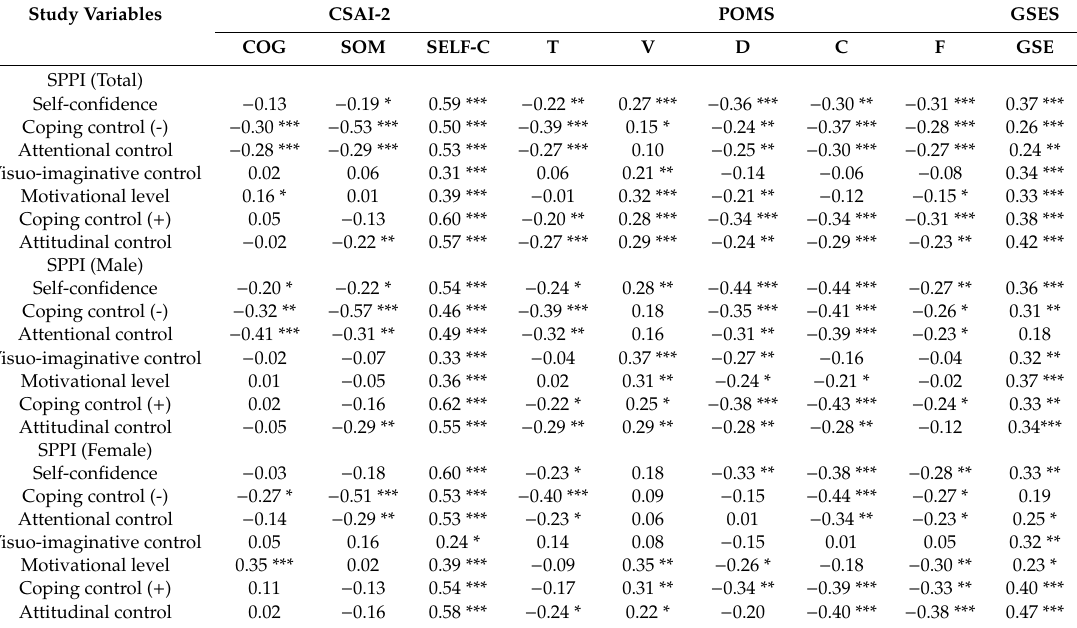
Table 3. Analysis of correlations between SPPI with CSAI-2, POMS and